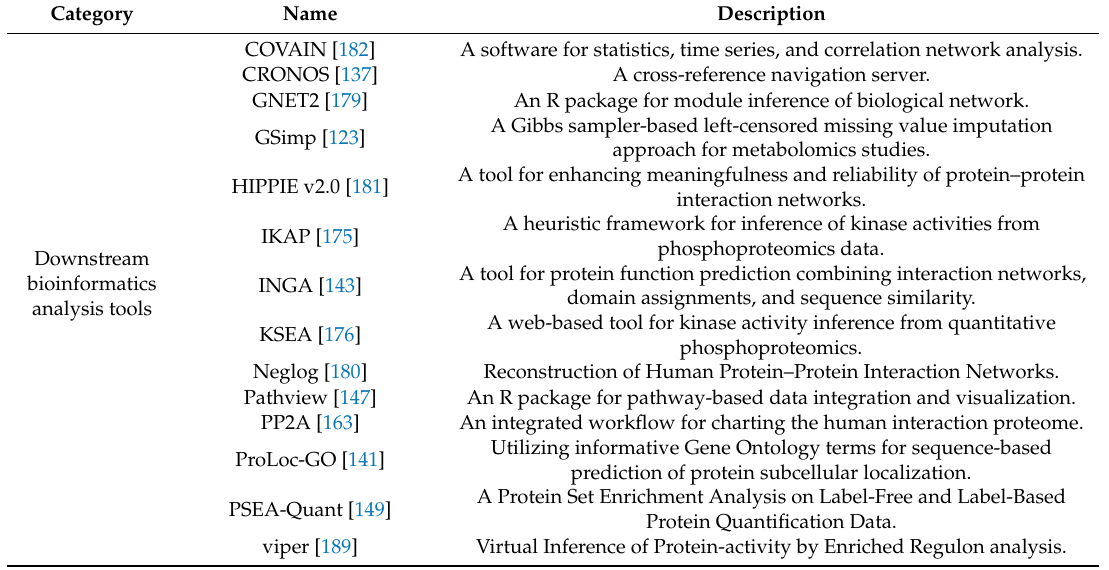
Table 3. Downstream bioinformatics analysis software